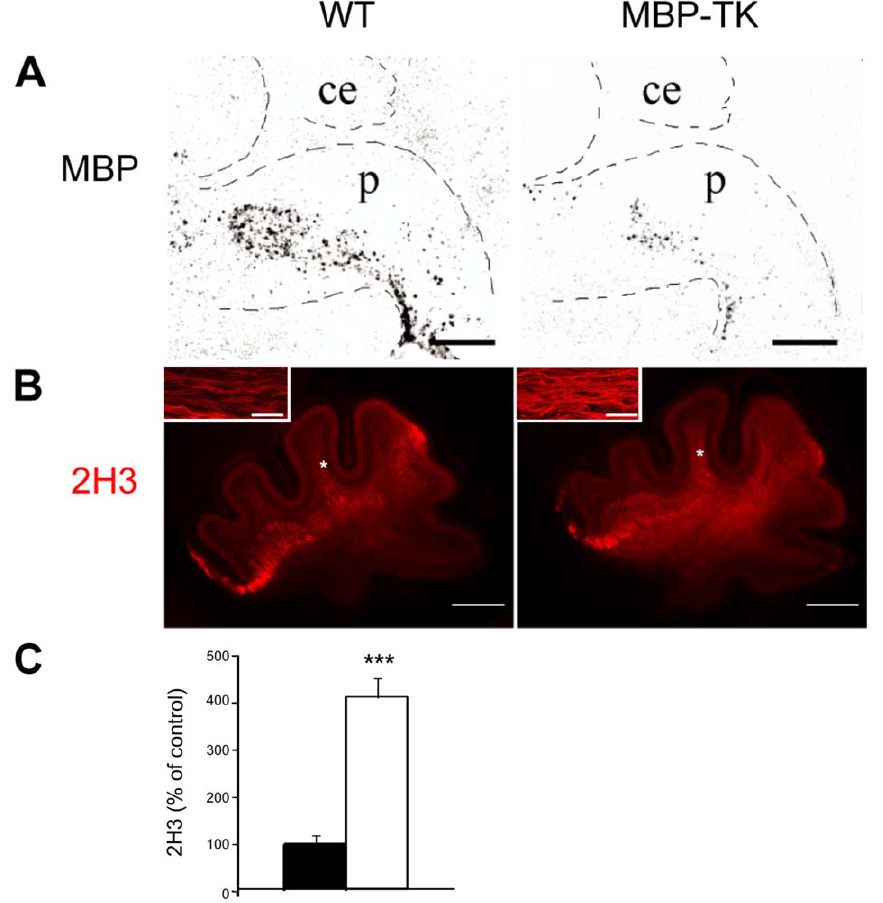
Figure 1. Sprouting of nerve fibers in MBP-TK mice after oligodendrocyte ablation. (A) MBP expression analyzed by in situ hybridization using a MBP specific riboprobe in WT (left panel) and MBP-TK (right panel) brain sections. Ce=cerebellum; p=pons. Scale bar: 500 m m. (B) Immunofluorescence analysis using an anti-neurofilament (2H3) antibody showing sprouting of nerve fibers in the cerebellar white matter tract of MBP-TK FIAU treated (right panel) compared to WT (left panel) brain sections. Scale bar: 200 m m. Insets show a magnification of the area marked by the asterisk in folia V (Scale bar: 10 m m). (C) Quantification of 2H3 fluorescence intensity in MBP-TK versus WT cerebella expressed as percentage of control. WT: black bar; MBP-TK: white bar. Values are mean 6 SEM. Student’s t-test: ***P ,